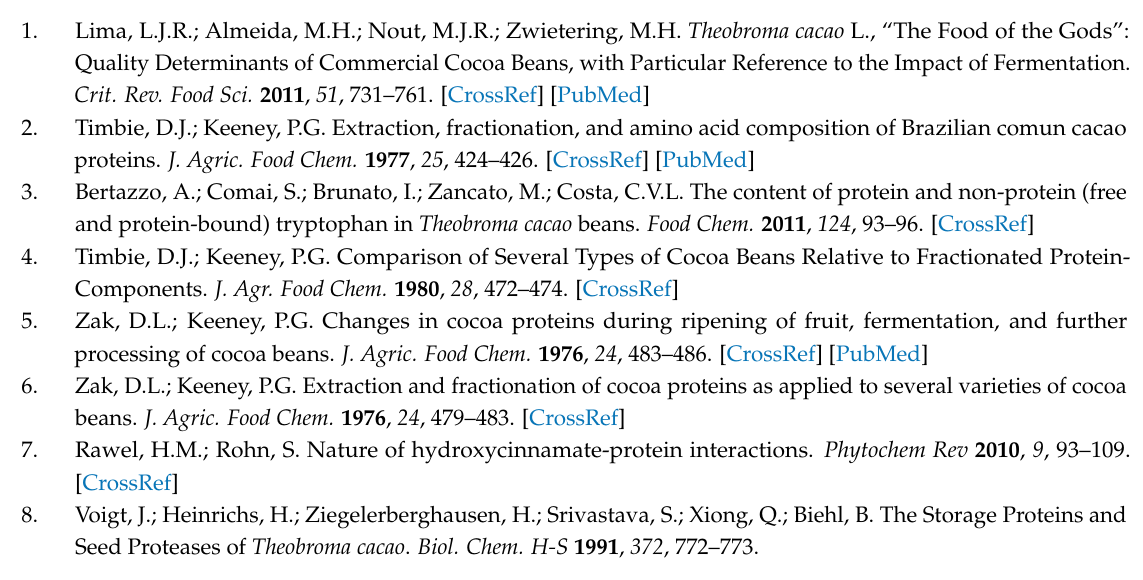
Table S1: Templates utilized for the homology model for vicilin from Theobroma cacao